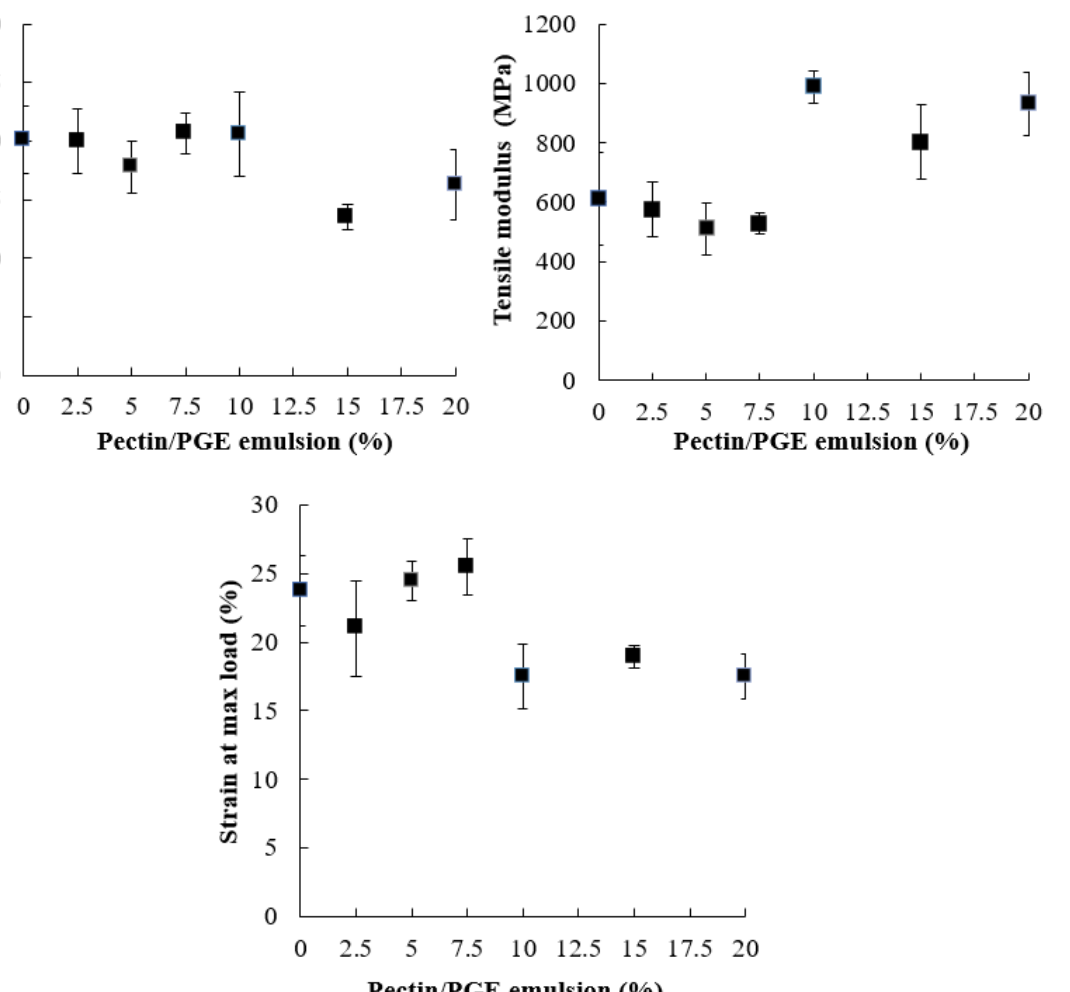
Figure 4. Tensile strength properties of CNFs/Pectin/PGE films with different loadings of PGE.